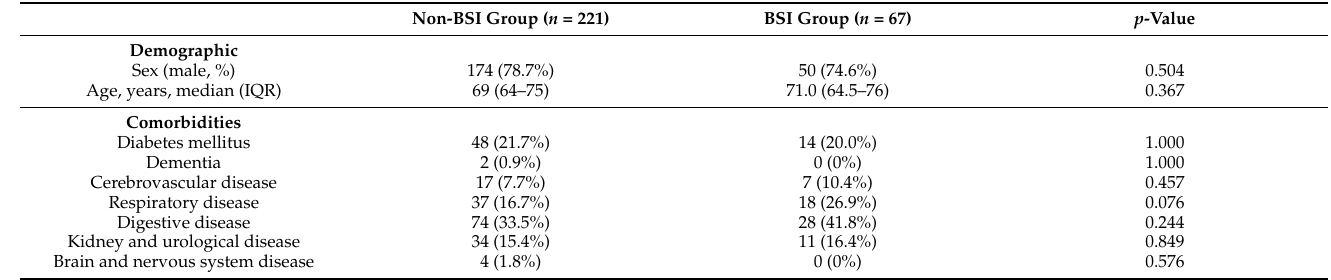
Table 1. Characteristics of bloodstream infections in patients with head and neck cancer. Non-BSI Group ( n =